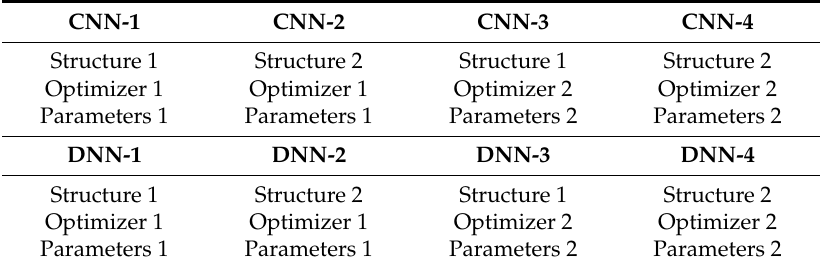
Table 3. Summary of the experimental setup of the di ff erent neural